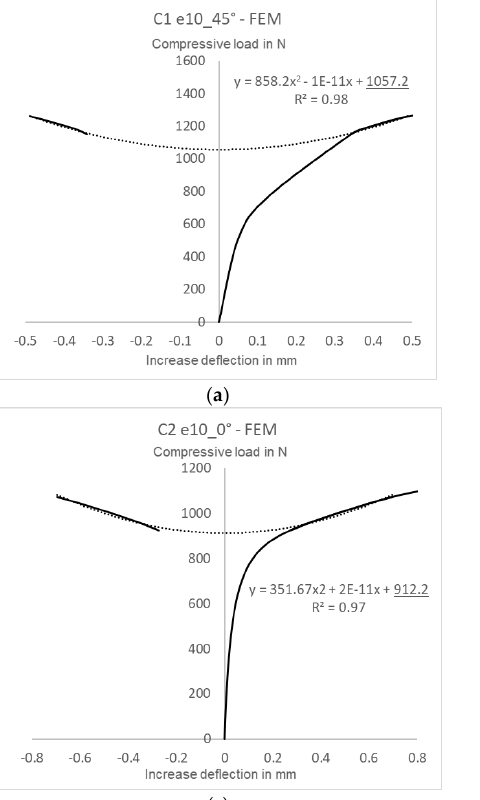
Figure 15. Eccentricity versus critical load for C2 [90/ − 45/45/0] s . The results of the postbuckling behavior of the compressed channel columns demon- strate that the deflection reflecting the lowest buckling modes increases when increasing the compressive load. The tests were conducted up to 200% of the bifurcation load. Figures